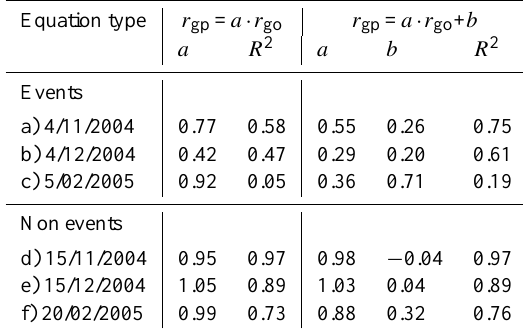
Table 5. Linear fits of observed ( r go ) , and predicted ( r gp ) global hourly radiation (MJm − 2 h − 1 ) at station 802 for certain